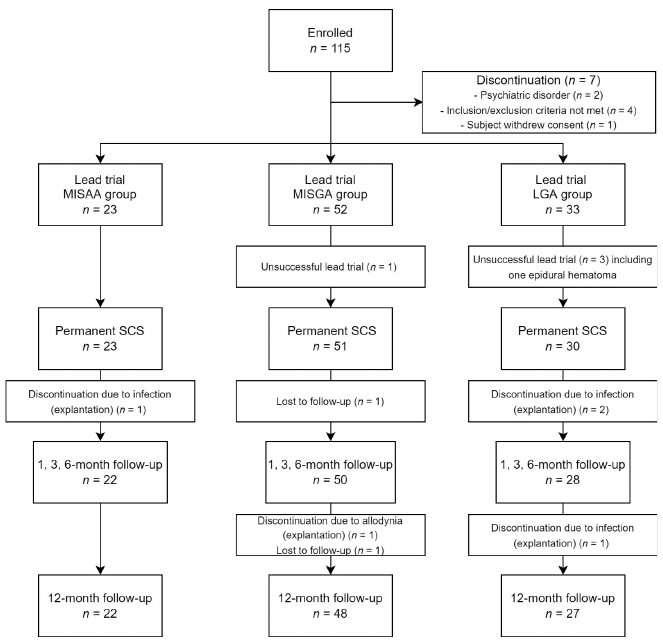
Figure 4. Study flow chart.